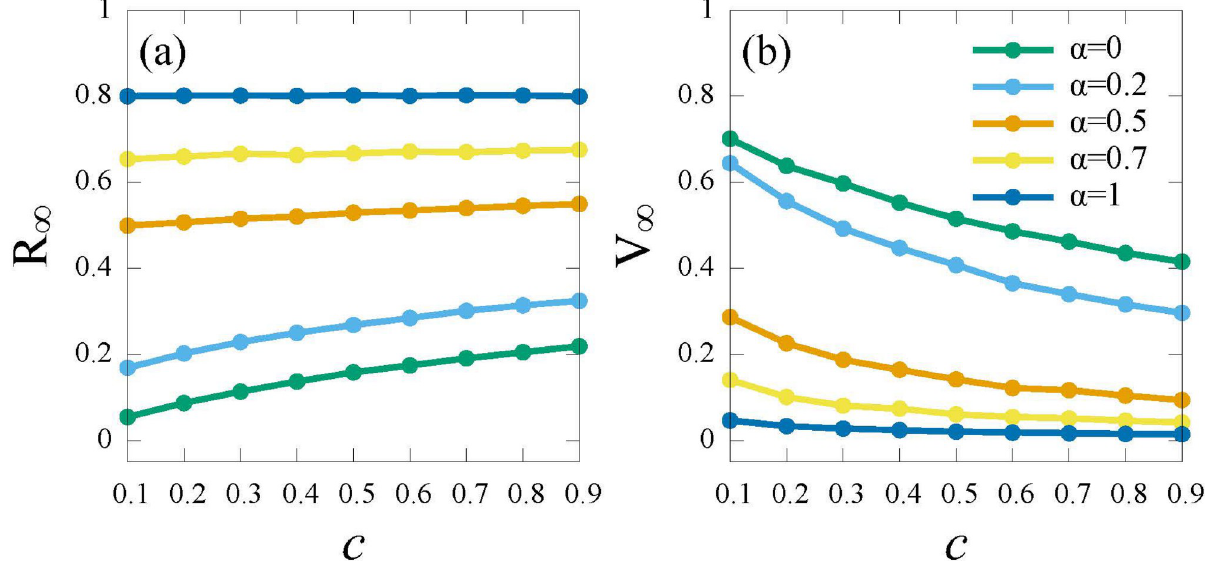
Fig 8. The epidemic scale R 1 and the vaccinate coverage V 1 versus cost ( c ) for different failure rate ( α ) under the RPS strategy. (a) R 1 ; (b) V 1 . Here, the infection rate λ = 0.5.